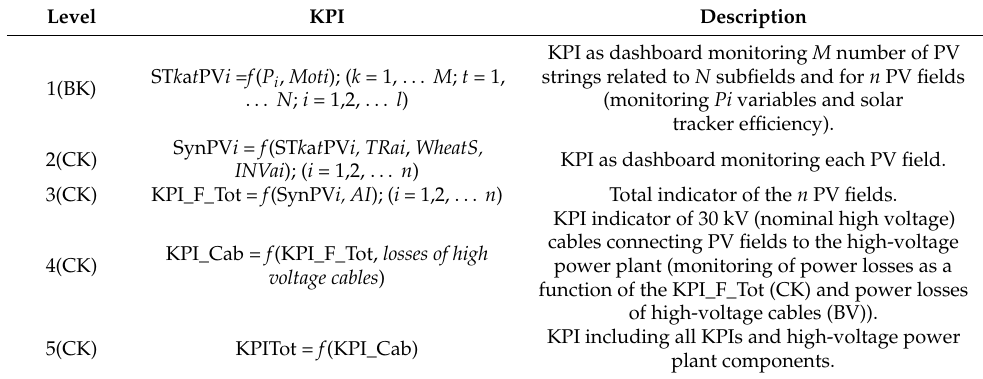
power plant components.